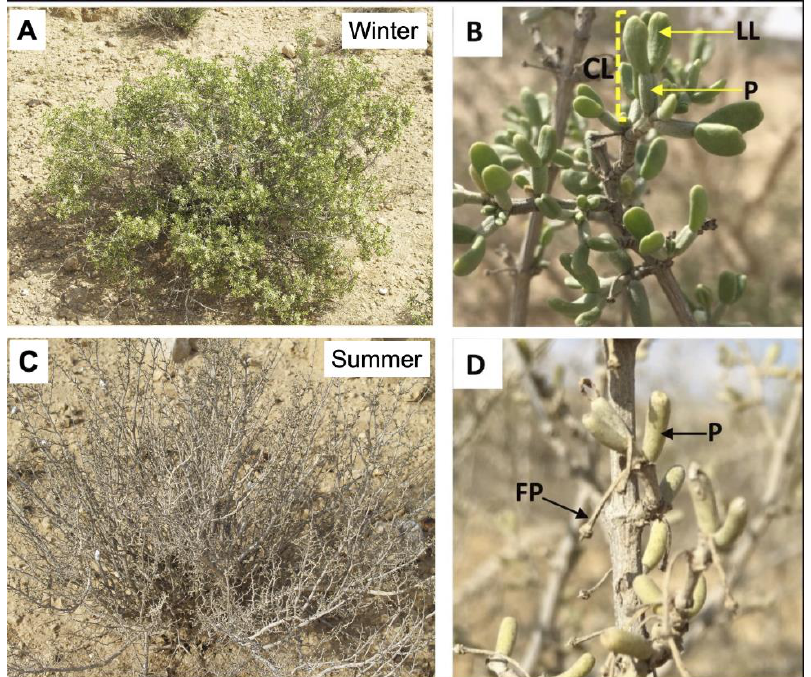
Figure 1. Phenology of Zygophyllum dumosum Boiss during the winter and summer of 2019 at Sede Boqer research area. ( A ) A typical appearance of Z. dumosum shrub during the wet season (winter). ( B ) Appearance of a Z. dumosum branch during the wet season carrying new compound leaves (CL) each consists of two leaflets (LL), which are carried on a thick and fleshy petiole (P). ( C ) Z. dumosum shrub appearance during the dry season (summer). ( D ) A Z. dumosum branch (dry season) carrying the remaining petioles. FP, flower pedicel.